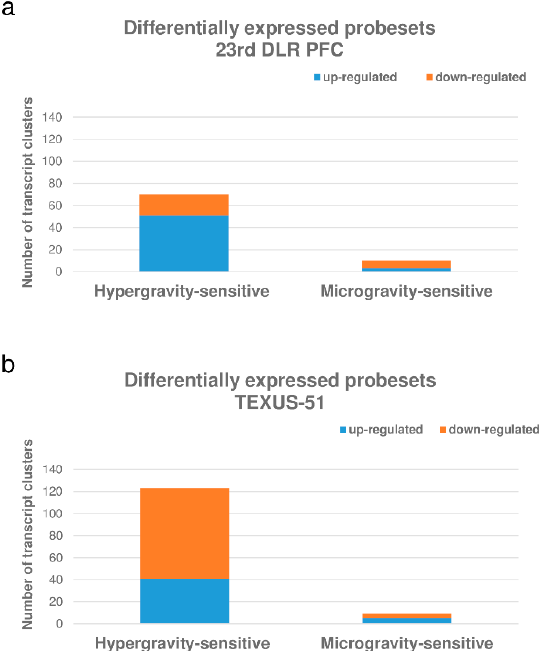
Figure 6. Distribution of differentially expressed probe sets representing HIF-related genes in human Jurkat T cells. ( a ) Number of hyper- and microgravity-sensitive probe sets (10 –2 -10 –3 g/1.8 g) identified in the 23rd DLR Parabolic Flight Campaign, ( b ) Number of hyper- and microgravity sensitive probe sets (10 –4 g/5–7 g) identified in the TEXUS-51 suborbital ballistic rocket campaign.